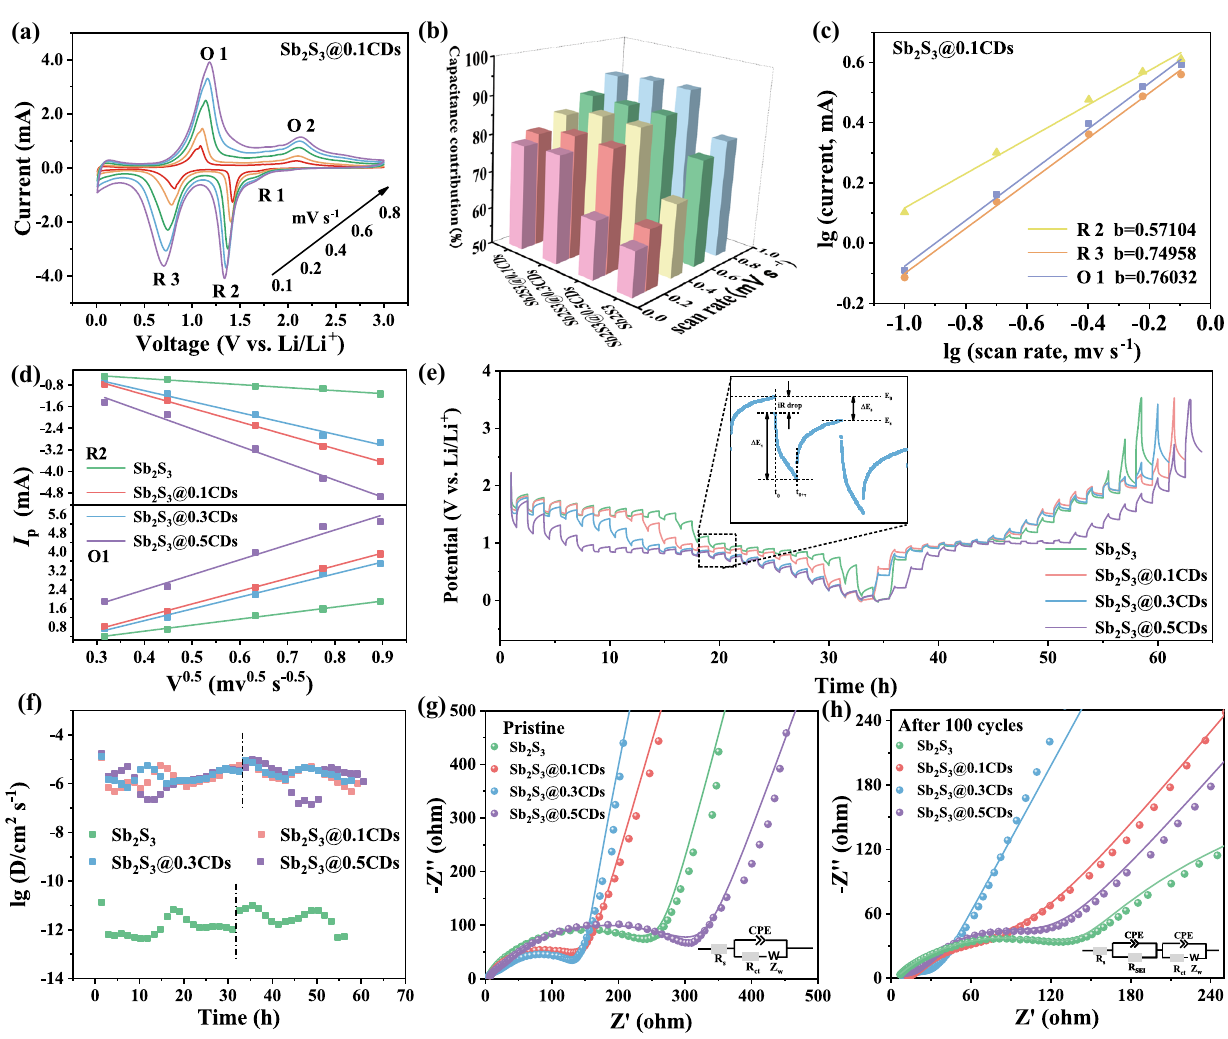
Fig. 10 Electrochemical kinetics mechanism. a CV curves of Sb 2 S 3 @0.1CDs electrode at different scan rates. b Capacitive contribution of stib- nite Sb 2 S 3 , Sb 2 S 3 @0.1CDs, Sb 2 S 3 @0.3CDs, and Sb 2 S 3 @0.5CDs at various scan rates. c Linear relations between log(v) and log(i) at peak cur- rents corresponding to the CV curves of Sb 2 S 3 @0.1CDs electrode. d Linear relations between Ip and log(i) of stibnite Sb 2 S 3 and Sb 2 S 3 @xCDs. e GITT potential profile of four samples and f the relationship between diffusion coefficient of Li + ions and time. Electron-transfer character of g pristine and h cycled cells is performed by the EIS from 100 to 0.01